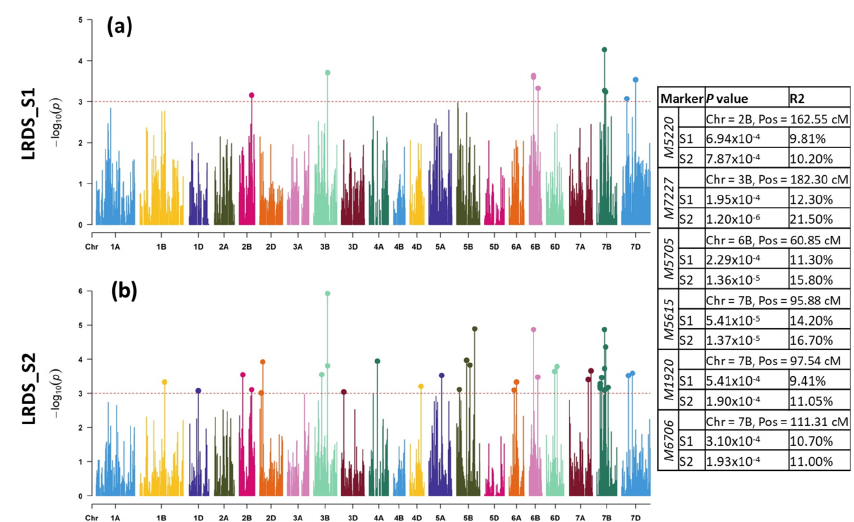
Figure 3. Genome-wide scan of ( a ) LRDS in S1 and ( b ) S2 in the form of Manhattan plots where the chromosomes are plotted at the bottom and the thin dotted red line indicates significance level at p -value < 0.001 ( − log10 = 3 or more) beyond which an association is counted as true association (highlighted dots). Table on the right shows common MTAs between S1 and S2 showing marker names, chromosome number, position, p-value, and R 2 value in each season.